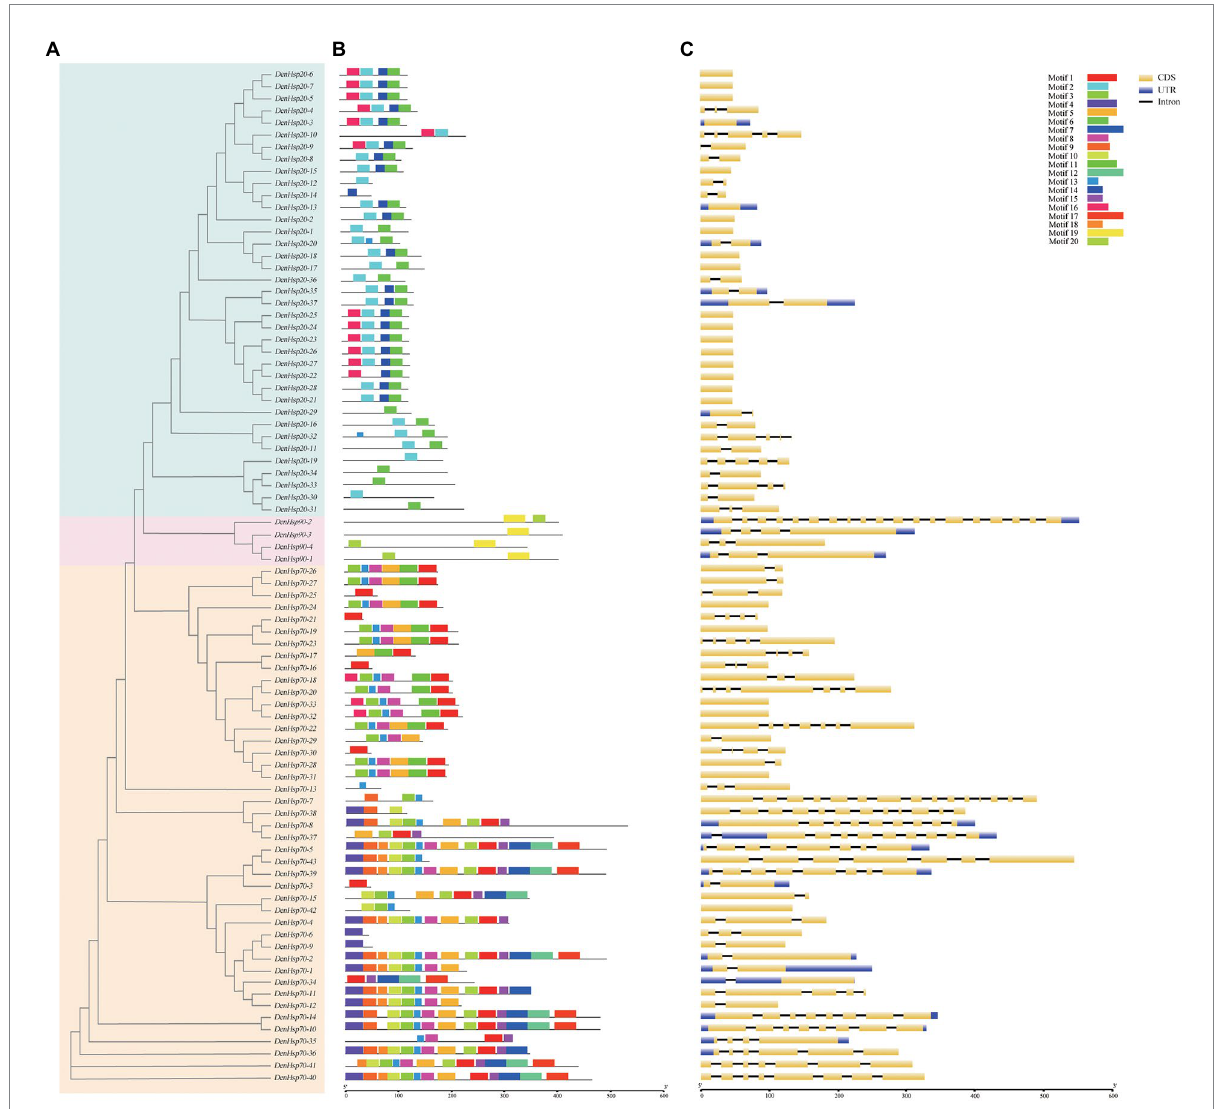
FIGURE 3 Phylogenetic relationships (A) , conserved motifs (B) and exon-intron structures (C) of Hsp20 , Hsp70 and Hsp90 genes in Dendrobium officinale . (A) Blue, red, orange colors represent Hsp20 , Hsp90 and Hsp70 genes. (B) The conserved motifs of 84 proteins were identified using MEME and visualized by TBtools. Different colors represent 20 different motifs. (C) Yellow and blue boxes are, respectively, indicating CDS and UTR. And the black lines indicate